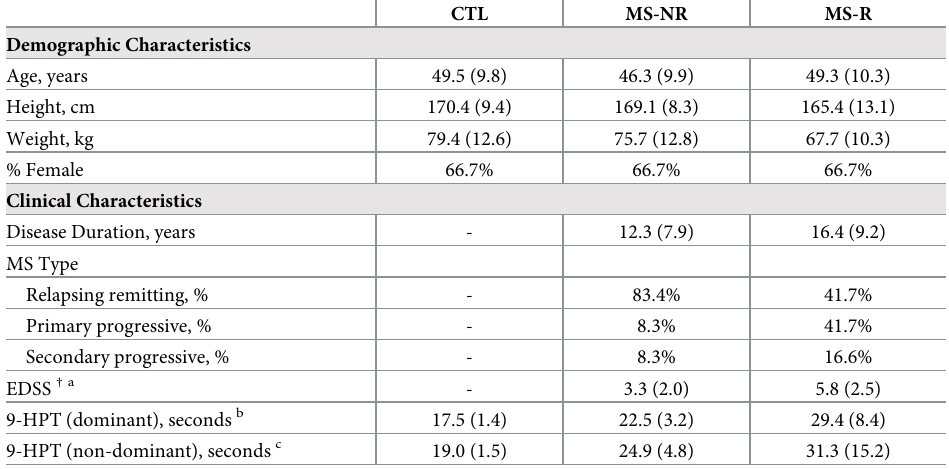
Table 1. Demographic and clinical characteristics for the three experimental groups. Values reported as mean (standard deviation), unless specified